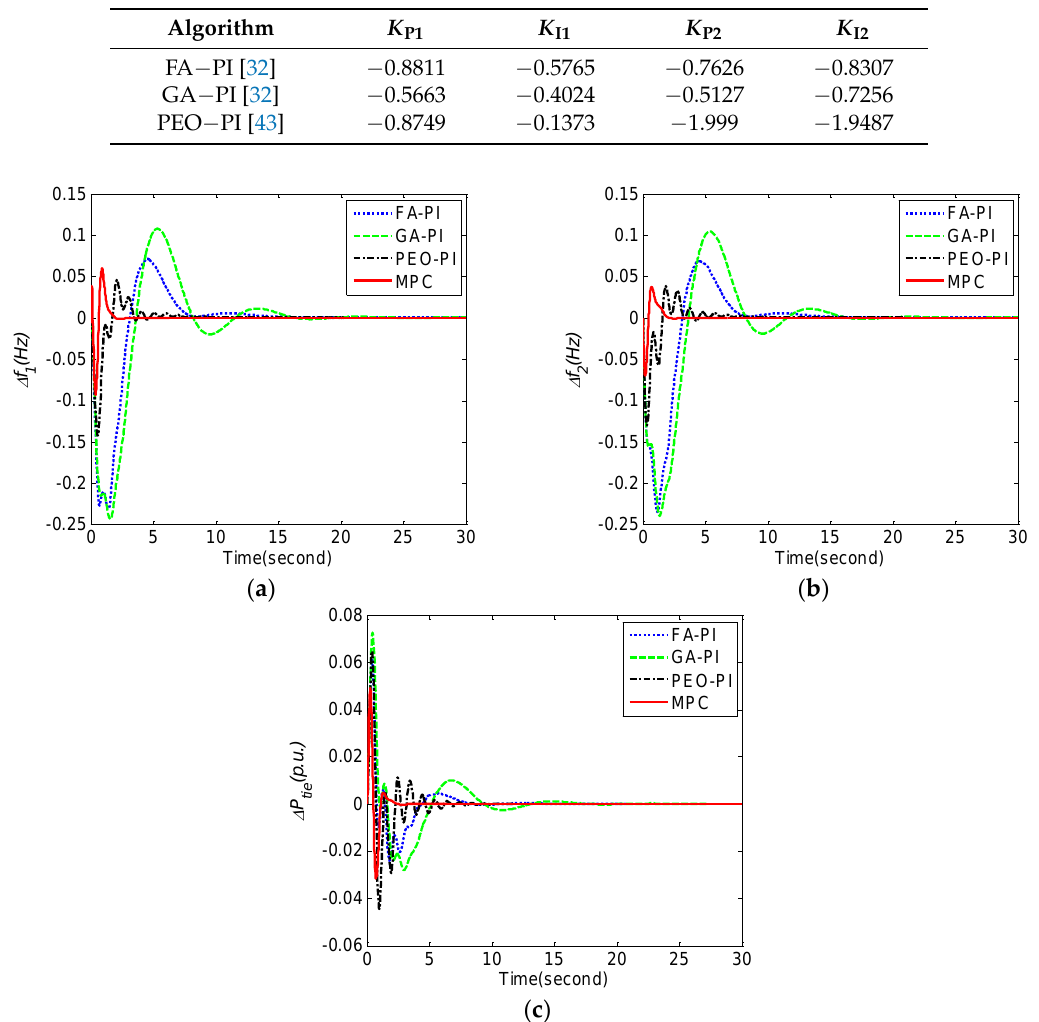
Table 3. Optimized PI parameters obtained by PEO-PI, GA-PI and FA-PI.